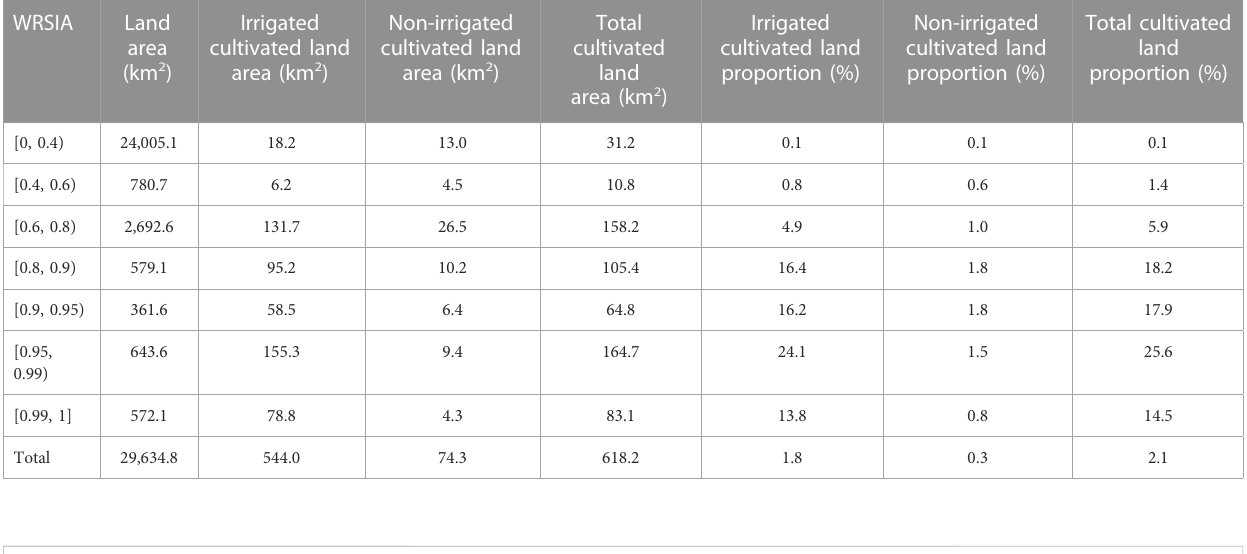
TABLE 2 Cultivated land distribution in different WRSIA ranges.